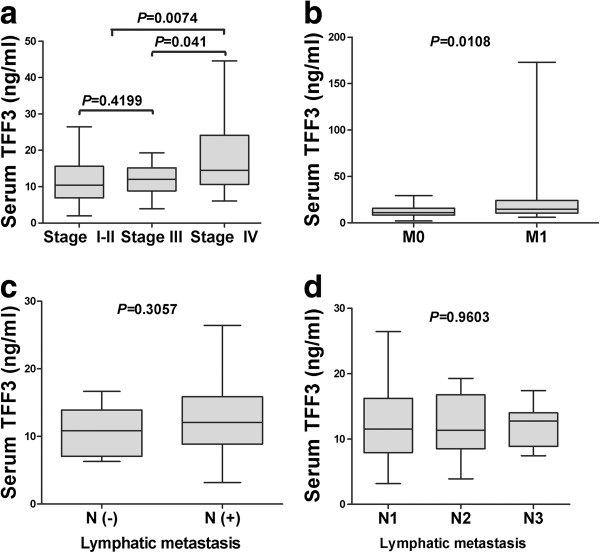
Measurement of serum TFF3 levels in gastric cancer patients. Serum TFF3 levels were compared in gastric cancer patients. The significant ratios with P < 0.05 between 2 groups(clinical stage III/IV) and another 2 groups (clinical stage I-II/IV) (a) The significant ratios with P < 0.05 between 2 groups M0 (patients without distant metastasis) and M1 (patients with distant metastasis) (b), lymphatic metastasis after excluding the interference of distant metastasis (c) and number of lymphatic metastases (d).